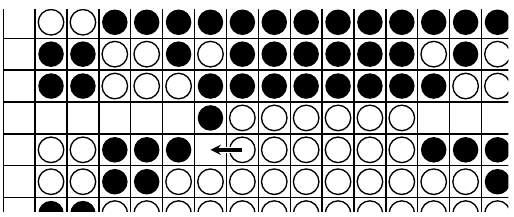
Figure 91. WHITE comes in.